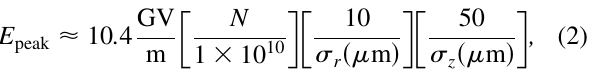
1. Changing transverse beam size ( (cid:3) ) r According to Eq. (2), the peak electric field is inversely proportional to the transverse beam size of the incoming bunch. Holding the other two variables ( N and (cid:3) ) constant z and varying the incoming beam’s transverse size, the elec- tric field is increased until the field ionization threshold is crossed. To observe the transverse beam size threshold, the waist location for the incoming beam was varied along the beam line using the two quadrupoles upstream of the plasma entrance. For the data set described, the waist was moved from 45 cm upstream of the plasma entrance to 55 cm downstream of the plasma entrance, in 5 cm increments with 10 events taken at each step.